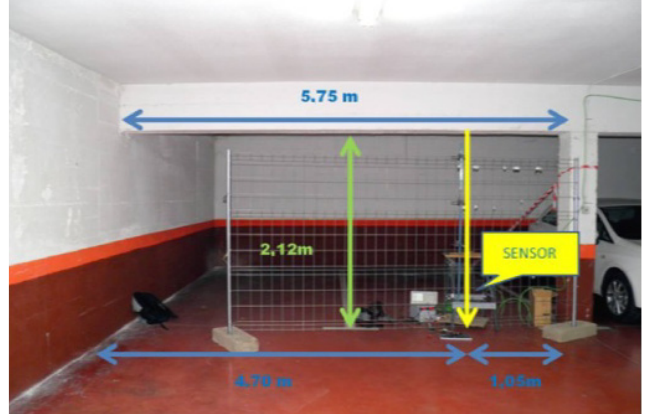
Figure 6. Schematic sensor positioning at the parking